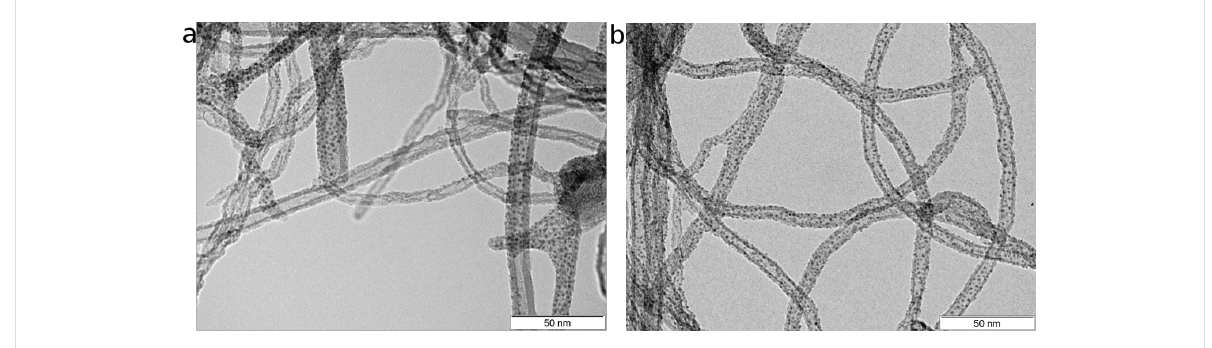
Figure 1: TEM images of the Pd-decorated MWCNTs (a) and Pt-decorated MWCNTs (b) resulting from the rf sputtering treatment.